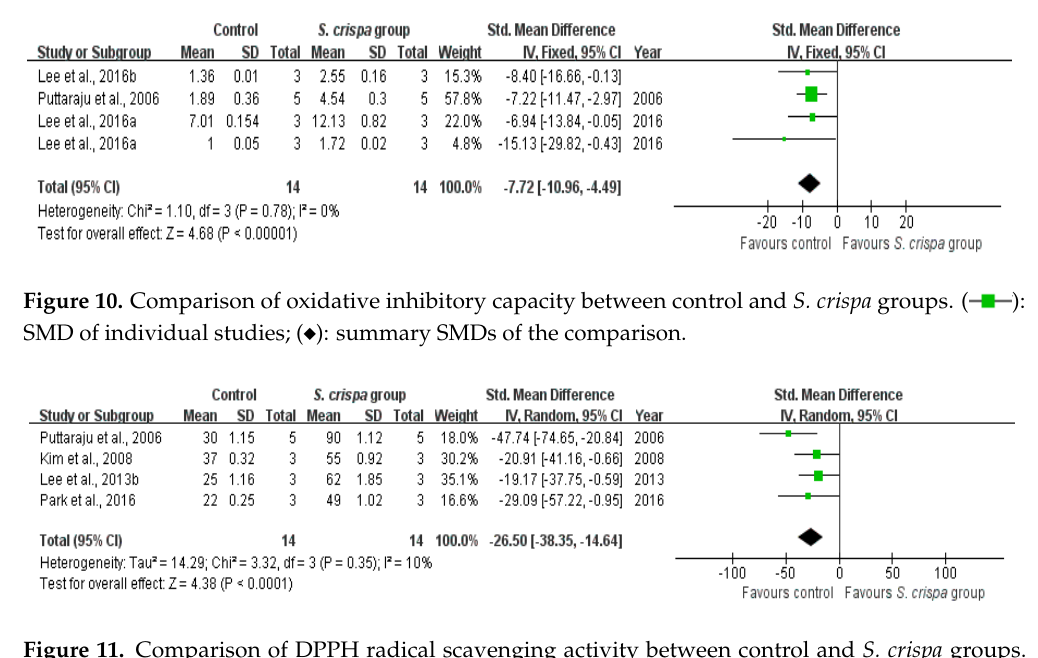
Figure 5. Comparison of levels of tumor activity between control and S. crispa groups. ( ): SMD of individual studies; ( ): summary SMDs of the comparison. Figure 6. Comparison of the IFN- γ production potential between control and S. crispa groups.